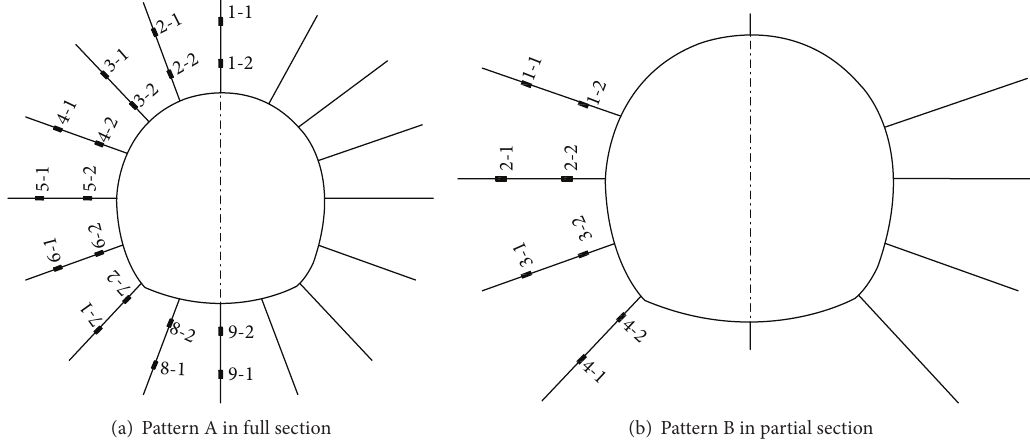
Figure 4: Arrangement of anchor